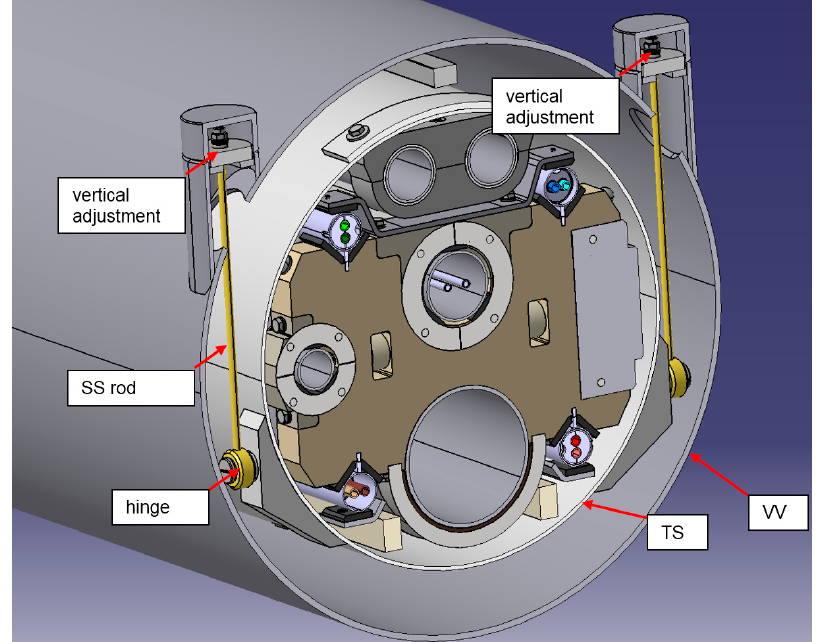
Figure 9. Suspension of the thermal shield (stainless steel rod version). Appl. Sci. 2020 , 10 , x FOR PEER REVIEW